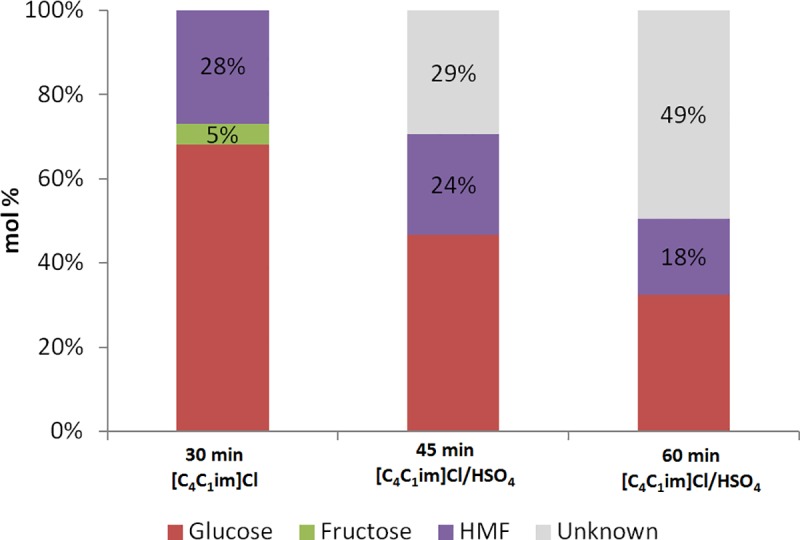
Yield of HMF from glucose at 90°C in pure [C4C1im]Cl and with subsequent addition of [C4C1im][HSO4], as determined by HPLC analysis.0.1 g glucose in 0.7 g [C4C1im]Cl, 8.1 mol% CrCl3·6H2O catalyst. 0.3 g [C4C1im][HSO4] was added after 30 min. The mixture was heated again and samples were taken 15 min and 30 min later.